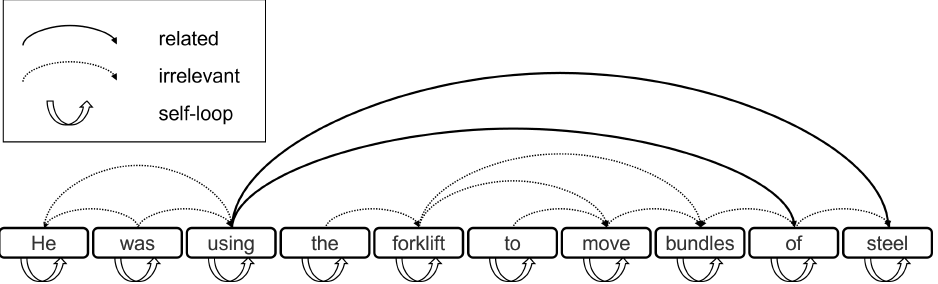
Figure 3. Example of an analytic syntactic structure. It should be noted that the syntactic structure in the figure is only an illustration and the relationships between words are not all listed. Moreover, in practical use, the input of the R-GCN is not the original text itself, but the text features embedded in the text after pre-training